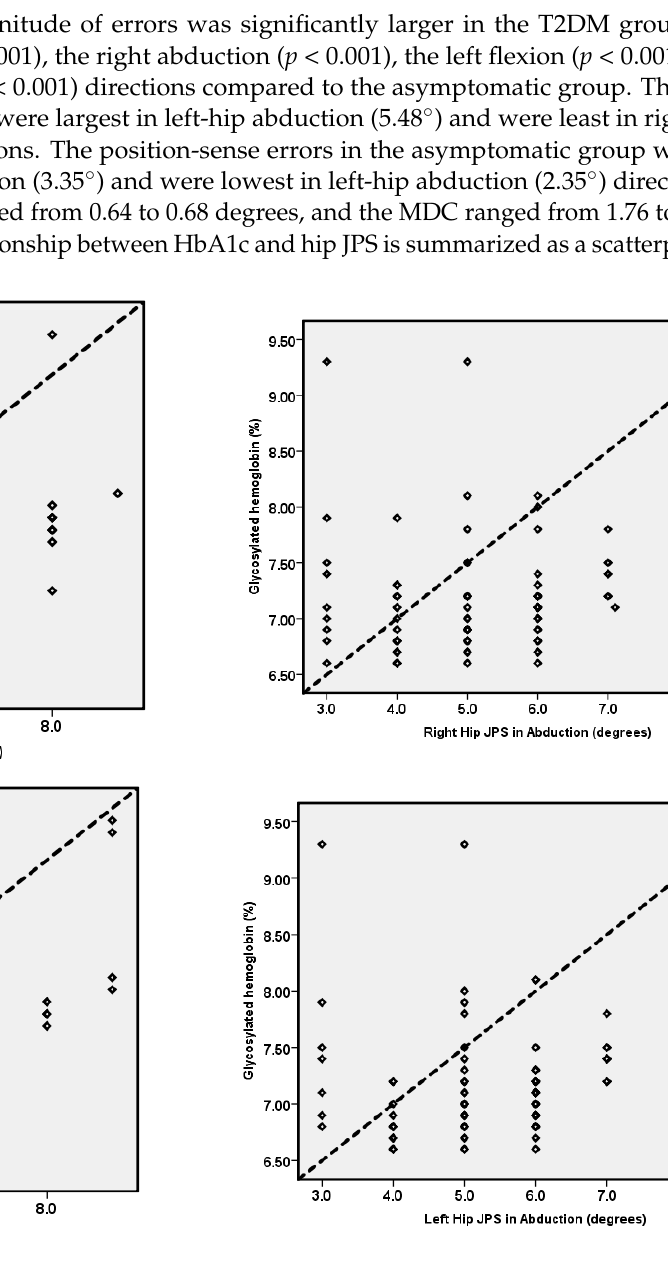
Figure 3. Relationship between HbA1c values and hip JPS in right- and left-hip flexion and abduction. HbA1c values showed a significant positive correlation with JPS in the right-hip flexion (r = 0.43, p < 0.001), right-hip abduction (r = 0.36, p < 0.001), left-hip flexion (r = 0.44, p < 0.001), and left-hip abduction (r = 0.49, p < 0.001) directions. As the HbA1c % increased, the hip JPS impaired, indicating that the greater the glycated hemoglobin levels, the worse the hip JPS. 4. Discussion This study aimed to compare hip JPS between the T2DM and asymptomatic groups and to assess the relationship between HbA1c values and hip JPS in T2DM individuals. This study showed that hip JPS errors were more prevalent in the T2DM group than in the asymptomatic group. Furthermore, there was a positive relationship between HbA1c values and hip JPS in the T2DM group. The decreased JPS in the T2DM group patients can be attributed to the effects of dia- betes on the nerve, such as hypoxia, small-fiber degeneration, and altered nociceptive feedback, which may alter the afferent proprioceptive input and impair the joint position sense [33,34]. A prior study by Ettinger et al. demonstrated that individuals with T2DM had impaired knee JPS compared to healthy individuals [35]. The T2DM individuals were 46% less accurate in matching the target angle [35]. There is a paucity of studies examining the proprioceptive responsiveness of the hip joint in individuals with type 2 diabetes, but there are several examining other peripheral joints [35–38]. The hip JPS declines observed in this study were consistent with previous reports presented by Maras et al. [38] in the ankle joint and by Haghighi et al. [37] in the knee joint. The mean absolute ankle and knee reposition errors were higher in T2DM individuals than in asymptomatic individuals [38]. Similar to our study results, Reddy et al. [22] aimed to compare cervical JPS between in- dividuals with T2DM and healthy individuals and to assess the correlation between HbA1c values and cervical JPS in individuals with T2DM. The participants with T2DM showed significantly larger cervical joint reposition errors in all directions compared with the healthy group (flexion: d = 1.23, p < 0.001; extension: d = 1.85, p < 0.001; left rotation: d = 1.70, p < 0.001; and right rotation: d = 2.60, p < 0.001). HbA1c showed a significant positive moderate correlation with cervical JPS in flexion (r = 0.41, p = 0.001), extension (r = 0.48, p < 0.001), left rotation (r = 0.38, p < 0.001), and right rotation (r = 0.37, p < 0.001), in partici- pants with T2DM [22]. Proprioceptive information is essential for maintaining balance and preventing falls in the elderly, and reduced JPS in T2DM patients will make these individuals susceptible to falls or injury [39]. Deursen et al. conducted a study on foot and ankle sensory neuropathy. They stated that diabetes impairs the function of peripheral sensory receptors, particularly muscle spindles, which may cause disturbances in balance